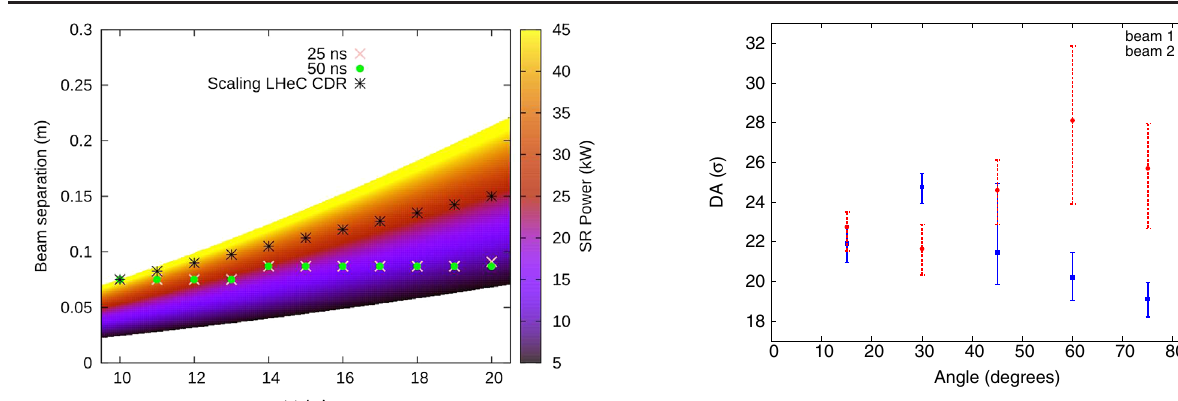
15 cm) and IP 1 ; 5 ¼